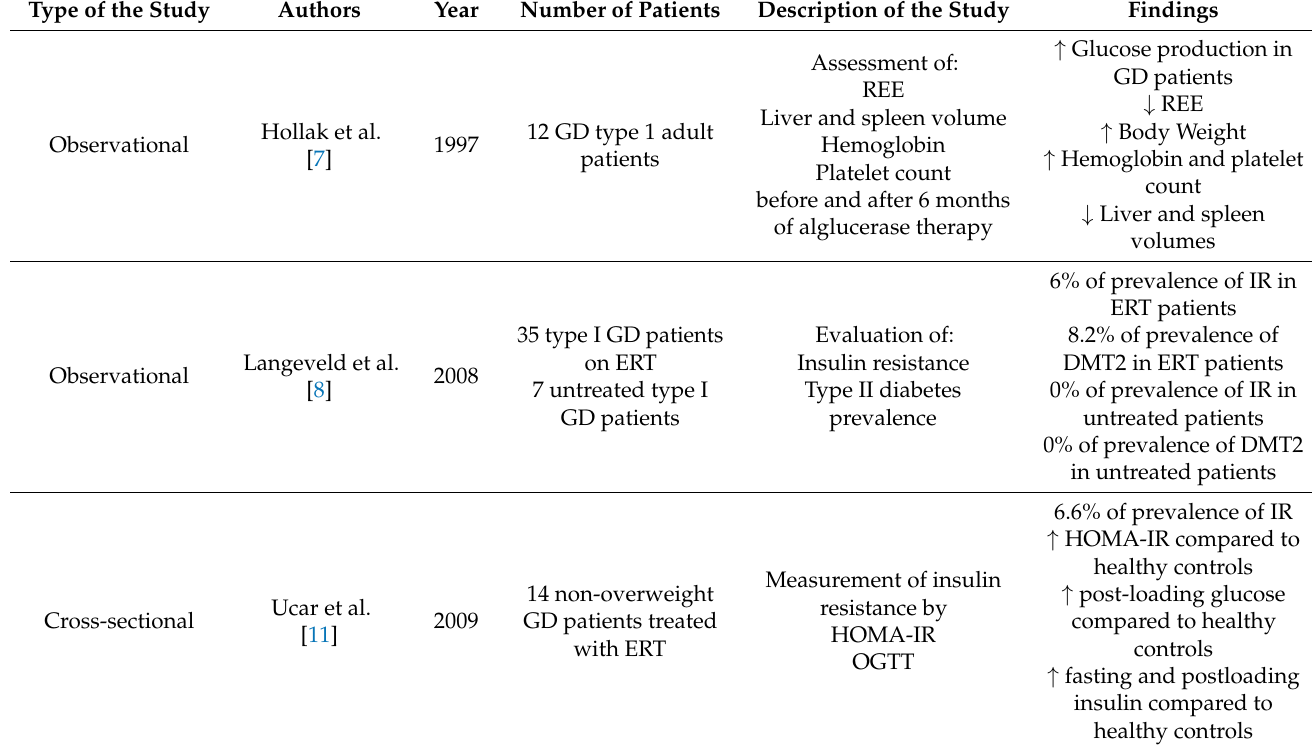
Table 1. GD manifestations and internal